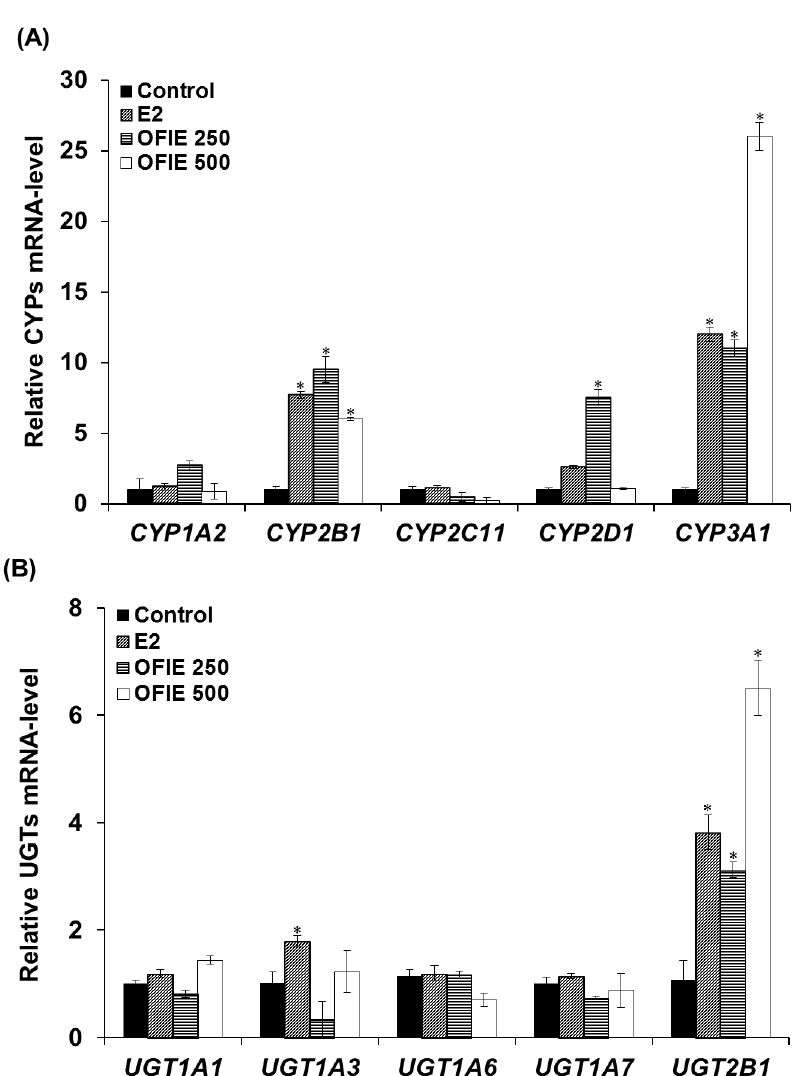
Figure 2. The mRNA expression levels of hepatic cytochrome P450s (CYPs) ( A ) and UDP-glucuronosyl transferases (UGTs) ( B ) in ovariectomized (OVX) rats after 5-week oral administration of Opuntia ficus indica fruit extract (OFIE). Each bar indicates the mean ± S.E. of triplicates. Control, the vehicle control-treated group; 17β-estradiol (E2, 0.5 mg/kg/day, positive control)-treated group; OFIE 250, (250 mg/kg/day)-treated group; and OFIE 500, (500 mg/kg/day)-treated group. Differences among gene levels in the various treatment groups versus those in the control group were determined with ANOVA followed by a Bonferroni-Dunn test. An asterisk indicates p < 0.001.